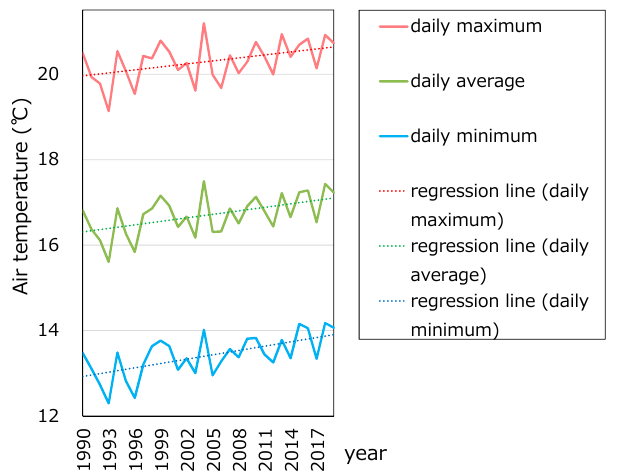
Figure 9. Trend in annual averages of air temperature. Air temperature: annual averages of daily maximum, daily average, and daily minimum of air temperature at all nine General sta.